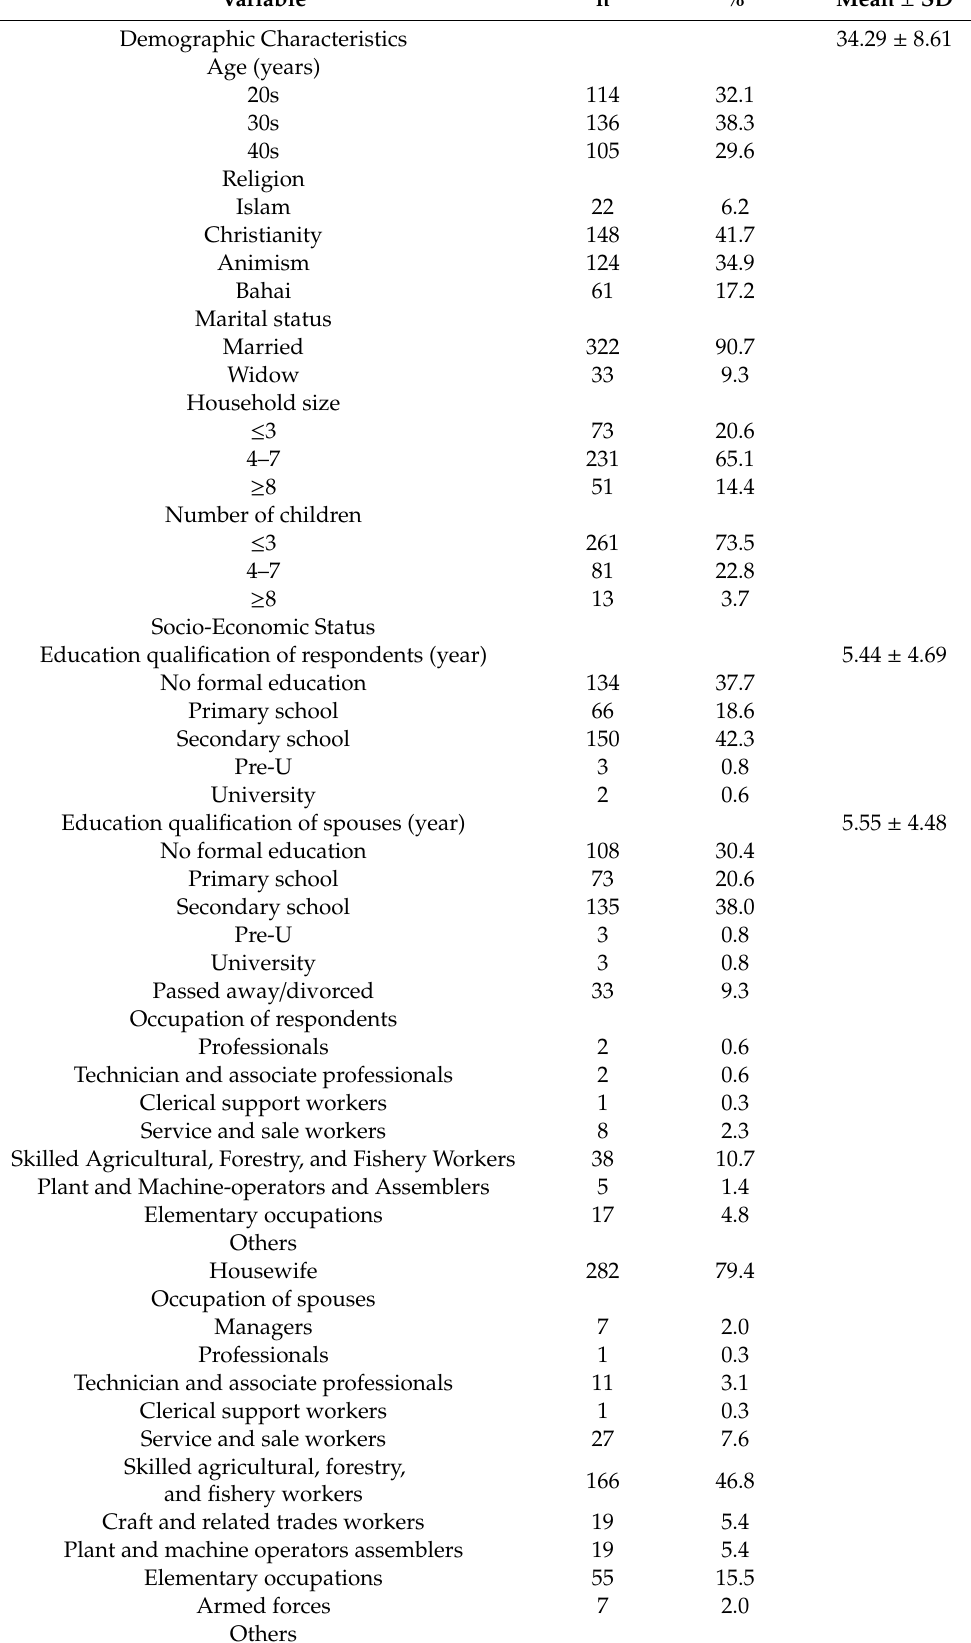
Table 2. Characteristics of the respondents ( n =